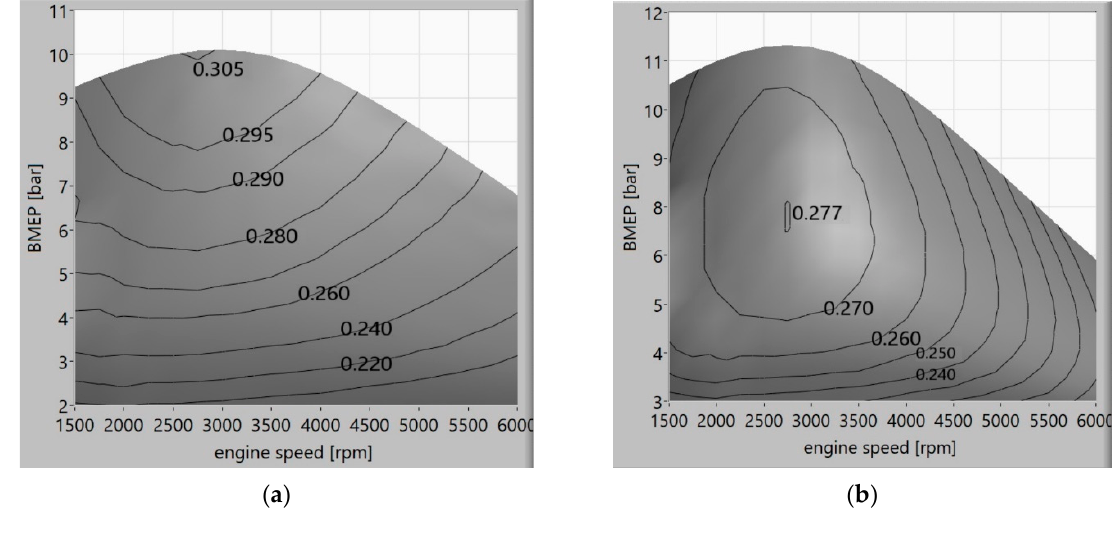
Figure 4. BTE maps of the hydrogen ‐ fueled engine.